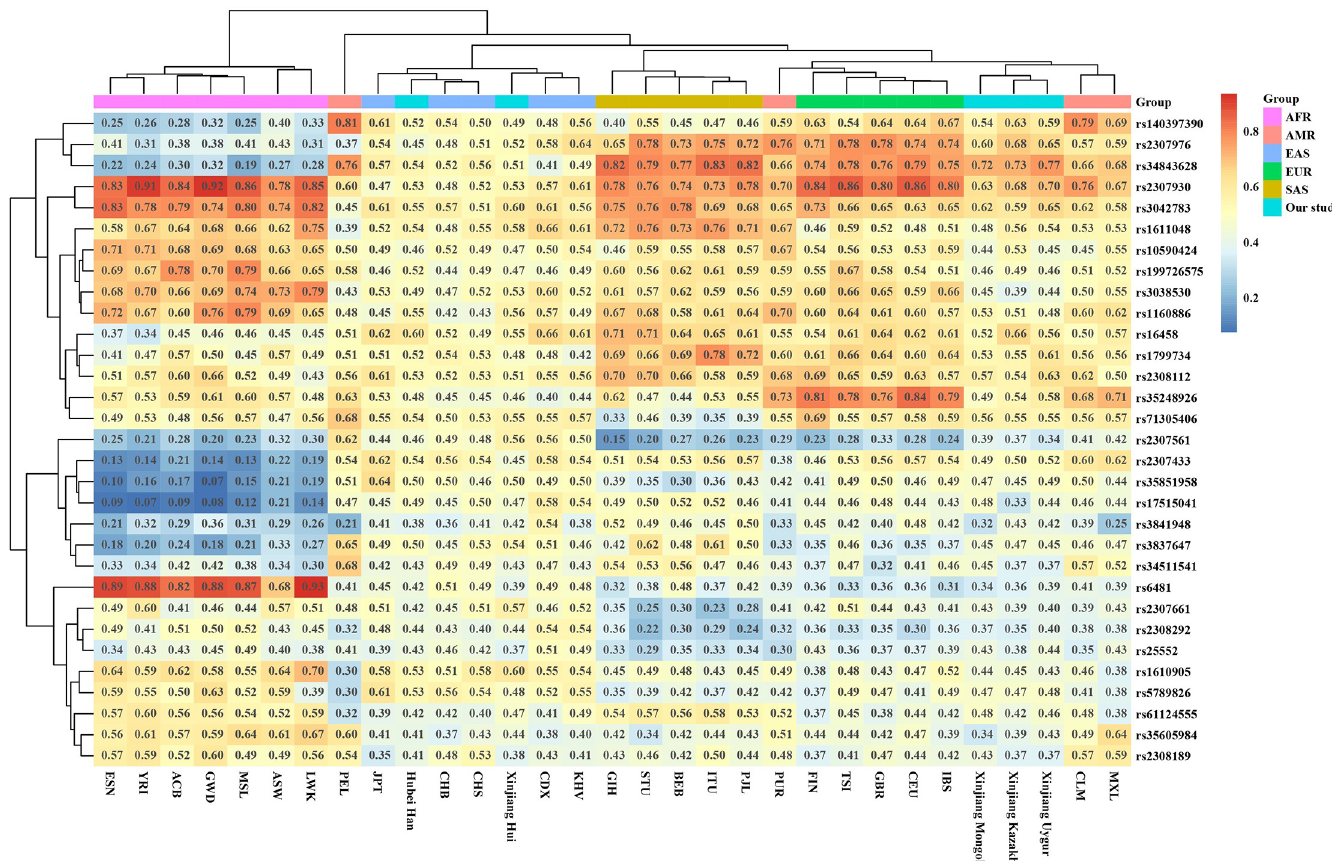
Fig 1. Heatmap of the 31 populations based on deletion frequencies of the 31 InDels in our study.